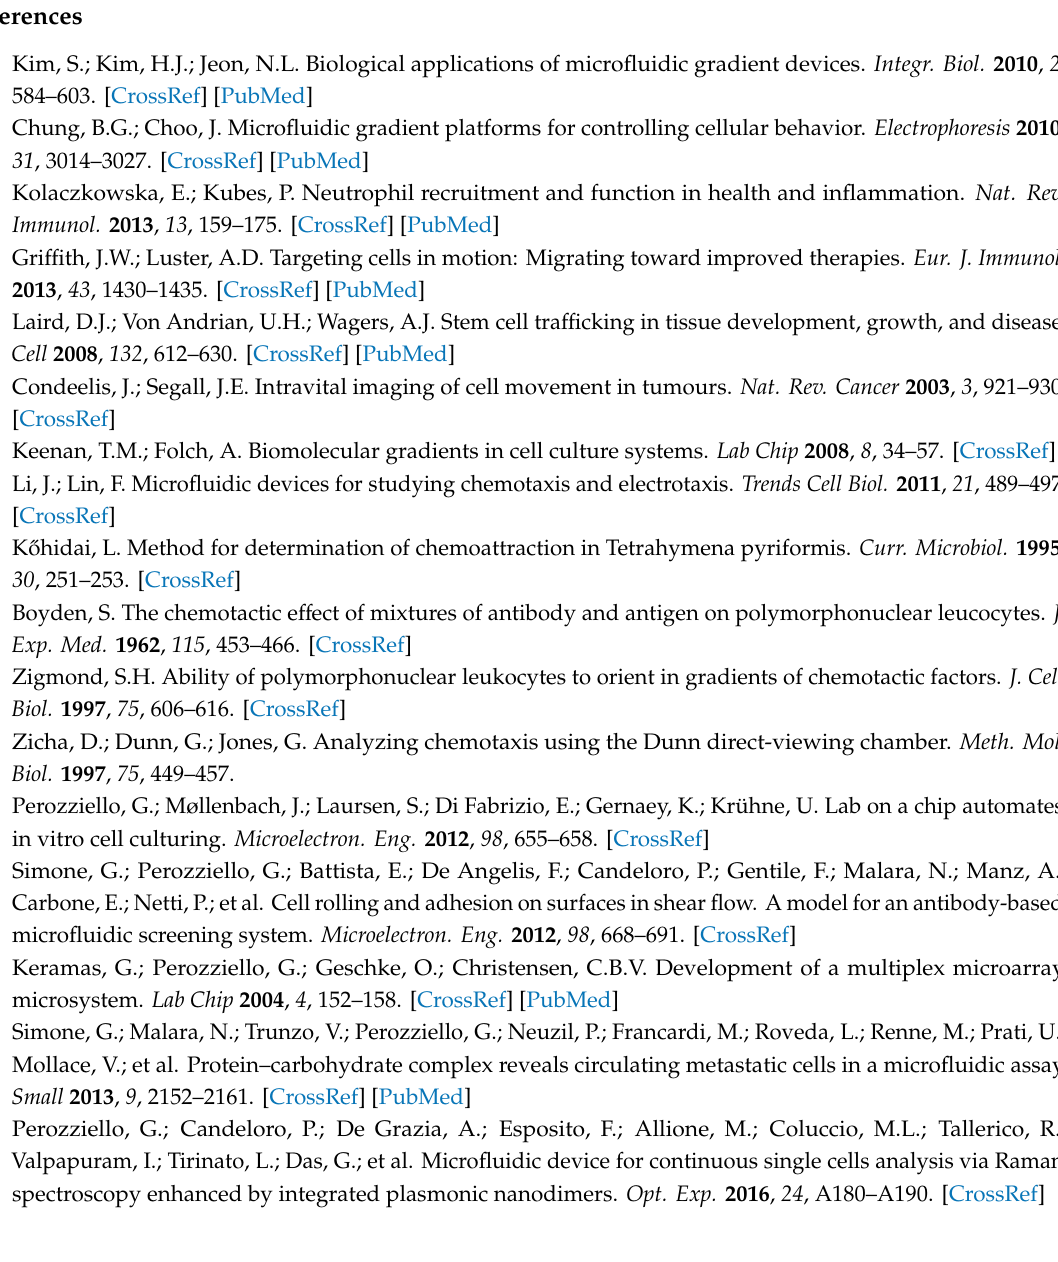
Figure S1: Concentration gradient formation in time-lapse and fitting curves, CAD file S1: Microfluidic device and Optical window 1, CAD file S2: Microfluidic device and Optical window 2, CAD file S3: Mini incubator 1_hidden components, CAD file S4: Mini incubator 1, CAD file S5: Mini incubator 2_hidden components, CAD file S6: Mini incubator